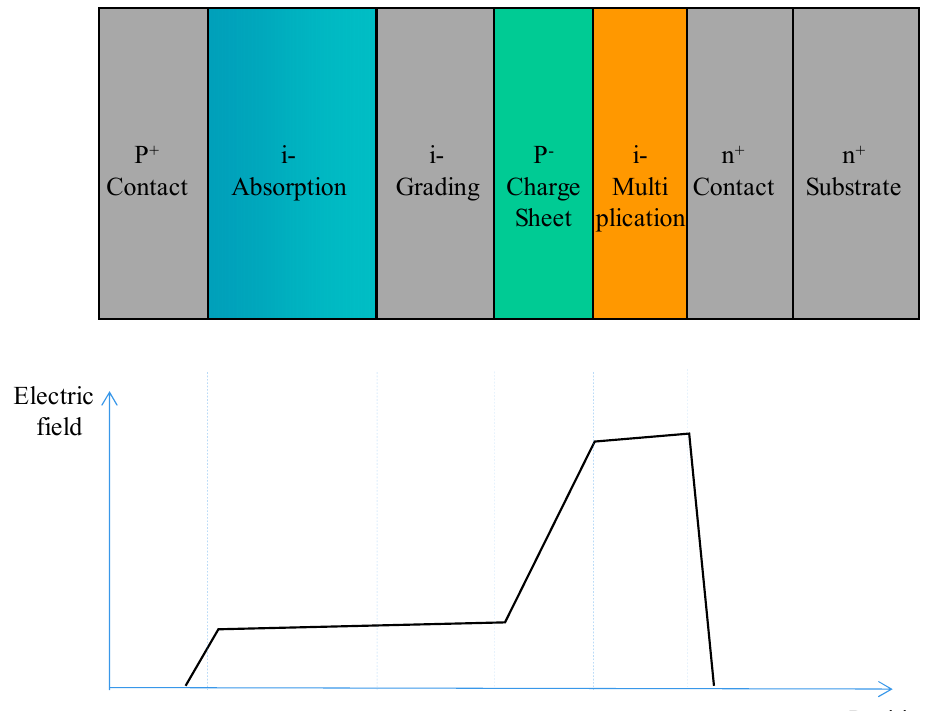
Figure 4. Typical schematic diagram and electric profile in the SAM APD.